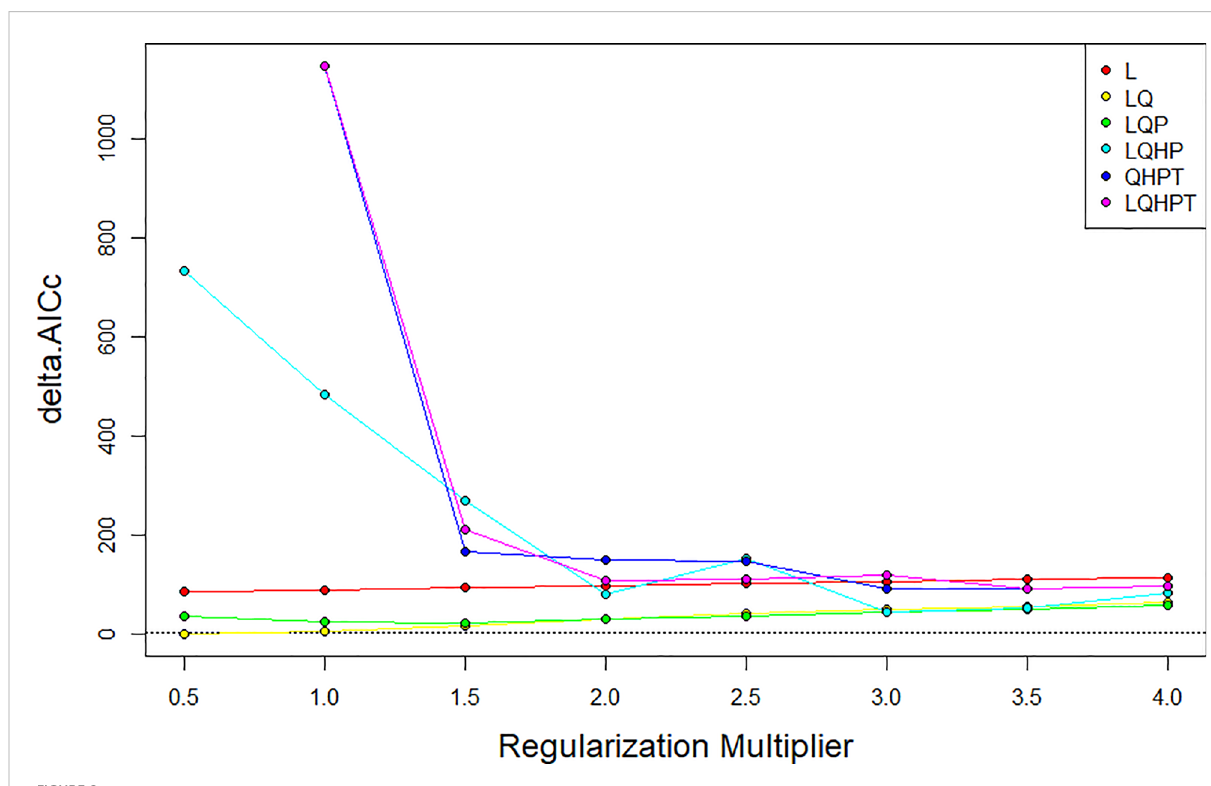
FIGURE 2 AICc value of parameter combinations based on the ENMeval calculation.